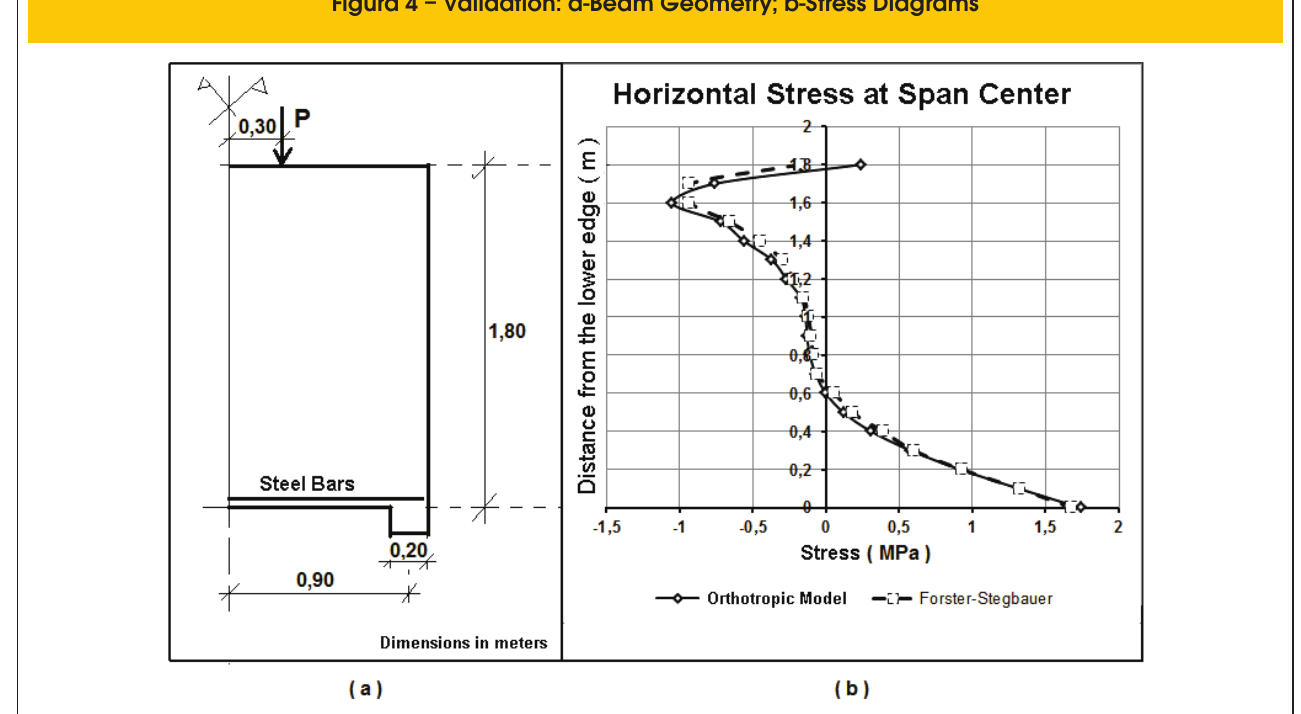
Figura 4 – Validation: a-Beam Geometry; b-Stress